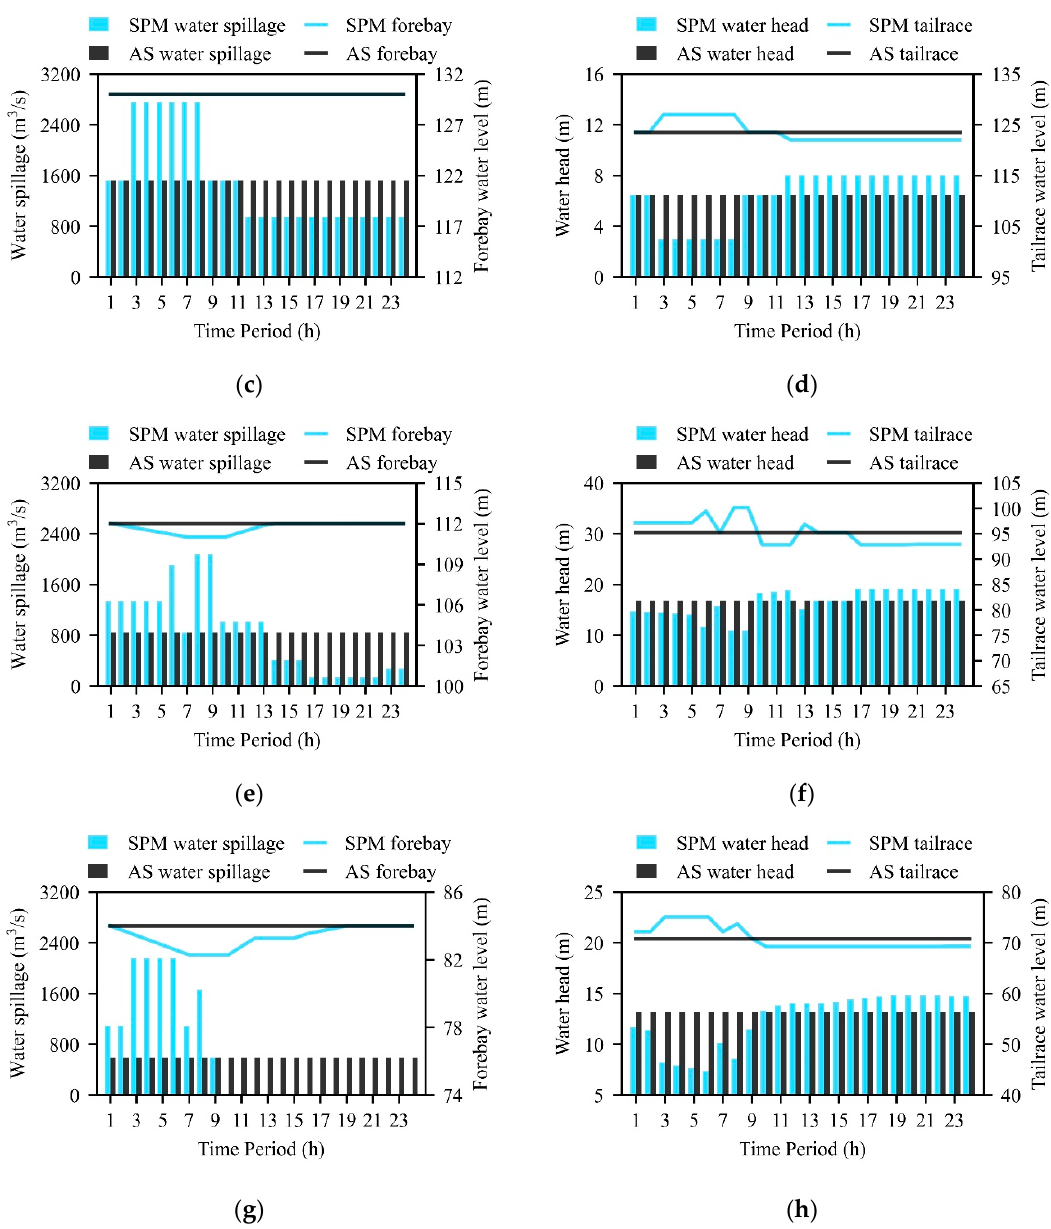
Figure 8. Comparison results of the cascaded system of SPM and AS. ( a ) Pingban water spillage and forebay water level; ( b ) Pingban tailrace water level and water head; ( c ) Bailongtan water spillage and forebay water level; ( d ) Bailongtan tailrace water level and water head; ( e ) Letan water spillage and forebay water level; ( f ) Letan tailrace water level and water head; ( g ) Qiaogong water spillage and forebay water level; ( h ) Qiaogong tailrace water level and water head.